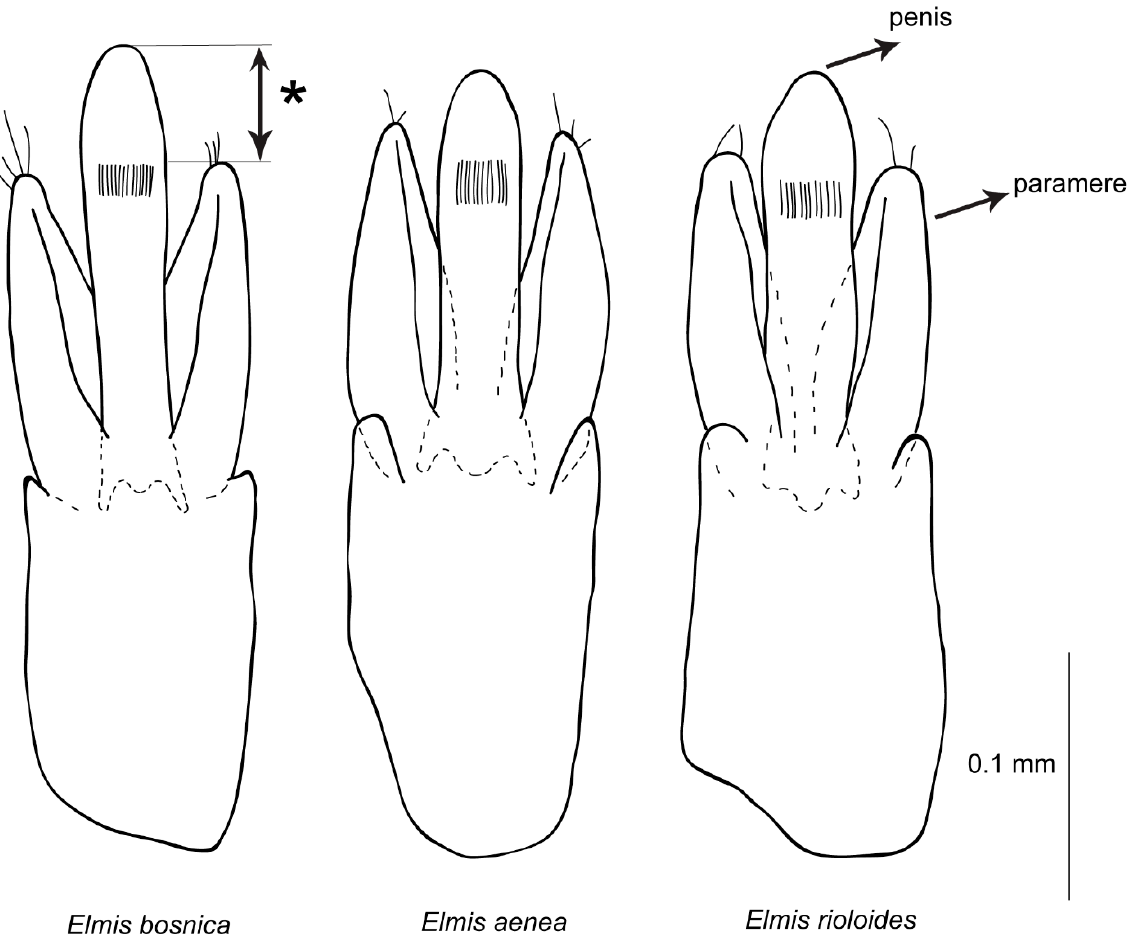
Figure 4. Drawing of the male genitalia of Elmis bosnica and two other species occurring in the same habitat in Southeastern Europe. * Distance from the tip of the paramere to the tip of the penis as the main identification character. The drawing of the male genitalia of E. aenea and E. rioloides was adapted from Olmi [74].